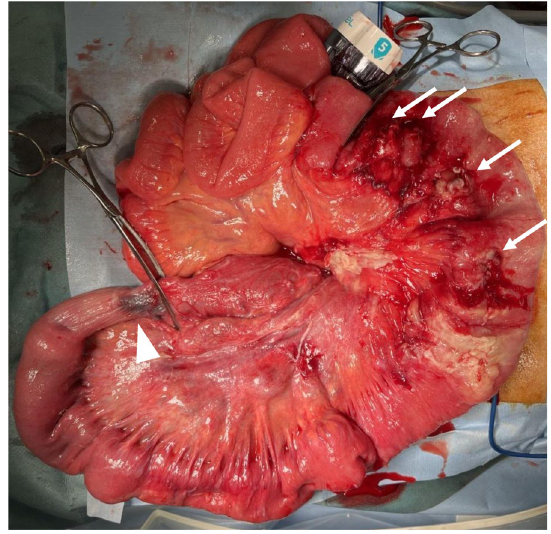
Fig. 4 Intraoperative findings after reducing intussusception. The tattoo around the polyp was located on the oral side of the intussuscepted segment (closed triangle) and multiple perforations were on the anal side (white